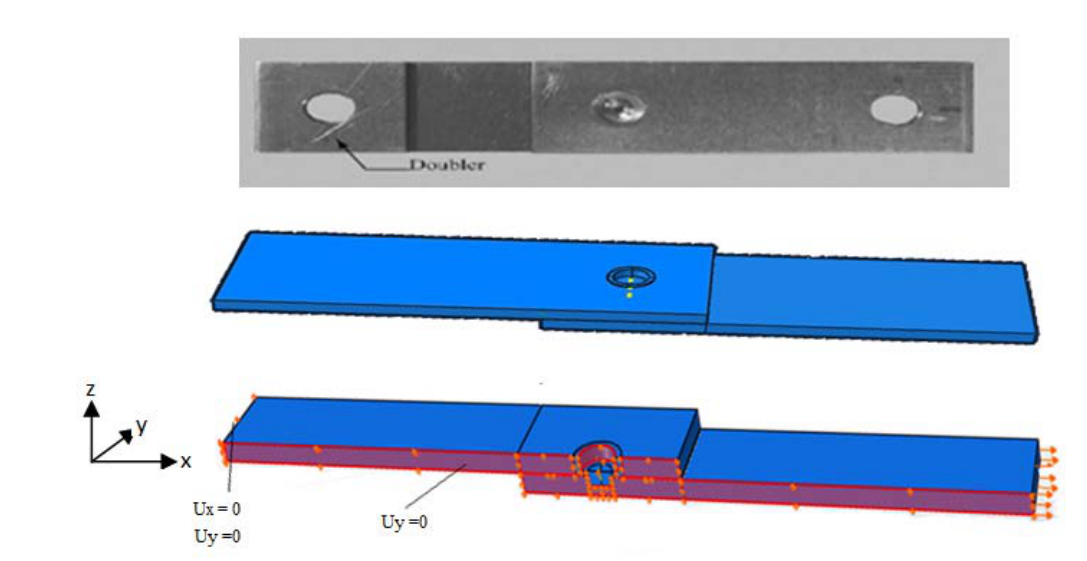
Figure 11: Geometrical model: half of a lap-shear joint, boundary condition and loading.